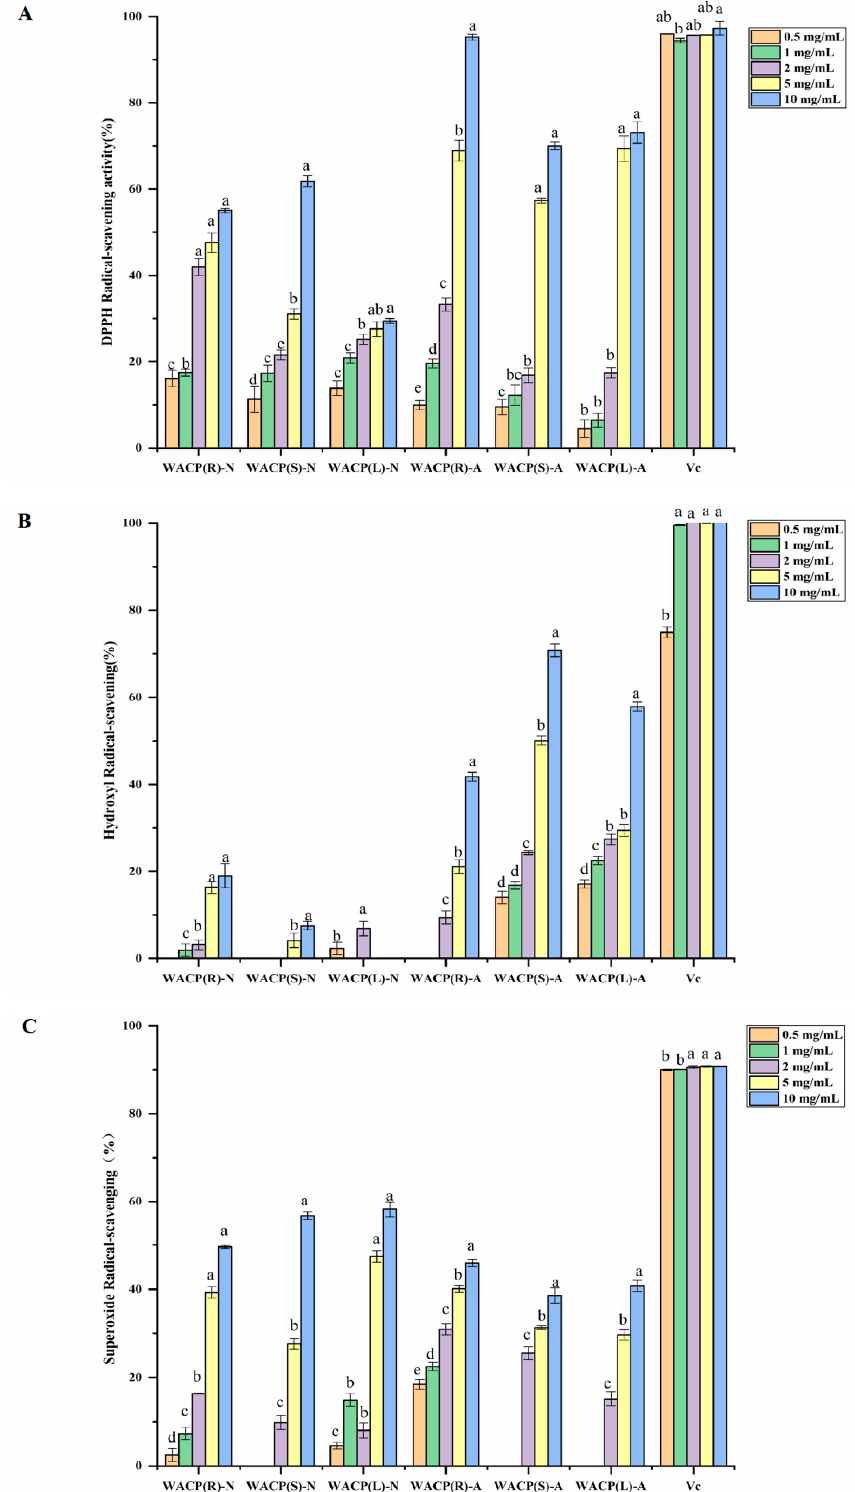
Figure 2. Scavenging ability of polysaccharide fractions on ( A ) DPPH radicals, ( B ) hydroxyl radicals and ( C ) superoxide anions. Vc was used as the positive control. Values are presented as means ± SD (n = 3). The same letter indicates that there was no significant change between different concentrations in the same group, and different letters indicate that there were significant differences between different concentrations in the same